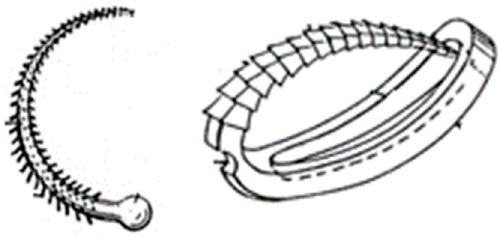
Figure 4. Dr. Yoon’s surgical devices with tapered or whisker-like barbs for endoscopic surgery [18,19].